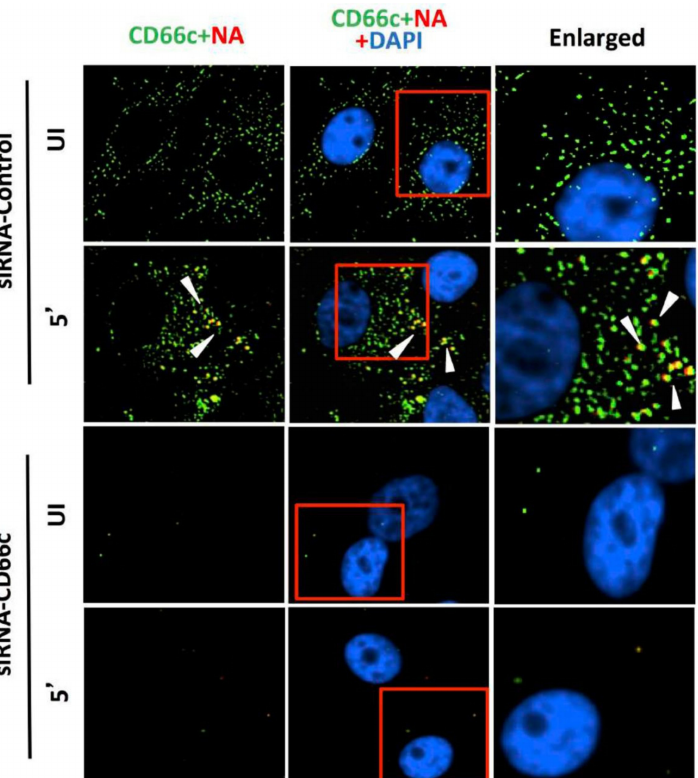
Figure 4. Knockdown of CD66c shows inhibition of virus binding on cell surface under fluorescent microscope. Here, UI denotes uninfected cells; 5 (cid:48) , Cells after 5 min of virus binding to them. Figure shows that A549 cells treated with siRNA control (negative) do not inhibit expression level of CD66c (green) and therefore binding of 5 multiplicity of infection (MOI) of PR8 viruses on cell surface can be seen. Figure shows colocalization between NA (red) and CD66c (green) in merged view (yellow) (second panel from top, pointed with white arrow). Amount of colocalization between NA and CD66c and absence of NA (red color) in control siRNA treated cells signifies possible colocalization between CD66c and NA at the host cell surface. The lowest two panels show diminished green signals in cells treated with CD66c siRNA suggesting a poor expression of CD66c protein (green). Consequently, virus binding on siRNA-CD66c treated cells is not seen, as evident by the absence of any green (CD66c) or red (NA) signal (bottom